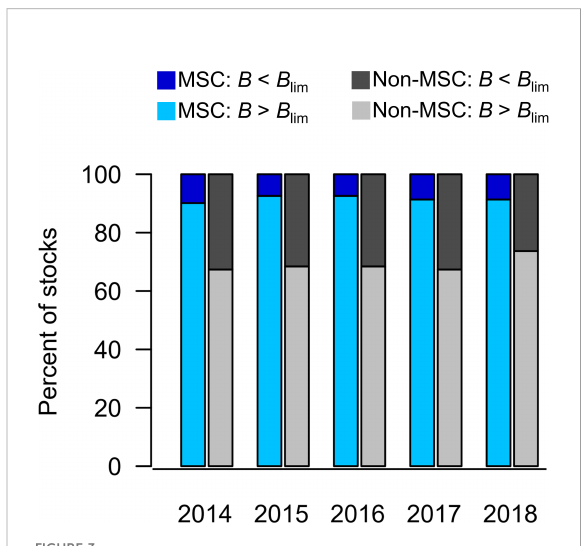
FIGURE 3 Proportion of MSC stocks (n = 81) and non-MSC stocks (n = 95) with biomass below or above limit reference points in years 2014-2018. Darker shades re fl ect stocks with biomass below the fl ect stocks ‘ over fi shed ’ threshold ( B < B lim ), and lighter shades re with biomass above B lim